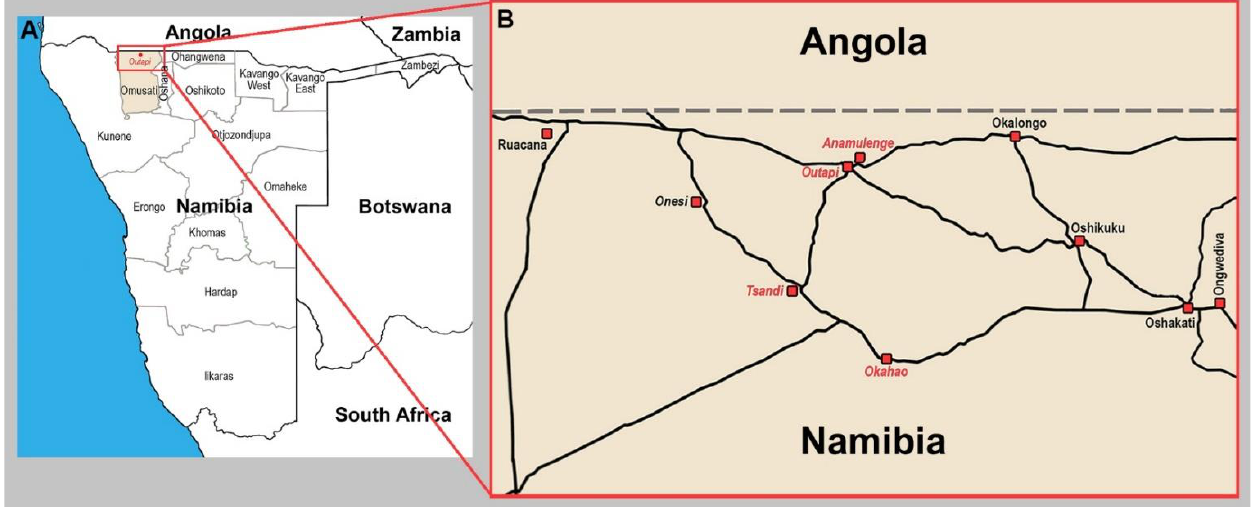
Figure 1. Map showing Namibia and its 14 regions. The Omusati Region and its capital Outapi are displayed in color ( A ). Close-up of the Omusati Region showing the main localities and roads. The localities that host large baobabs are written in italics and the localities that host the investigated historic baobabs are in red ( B ).